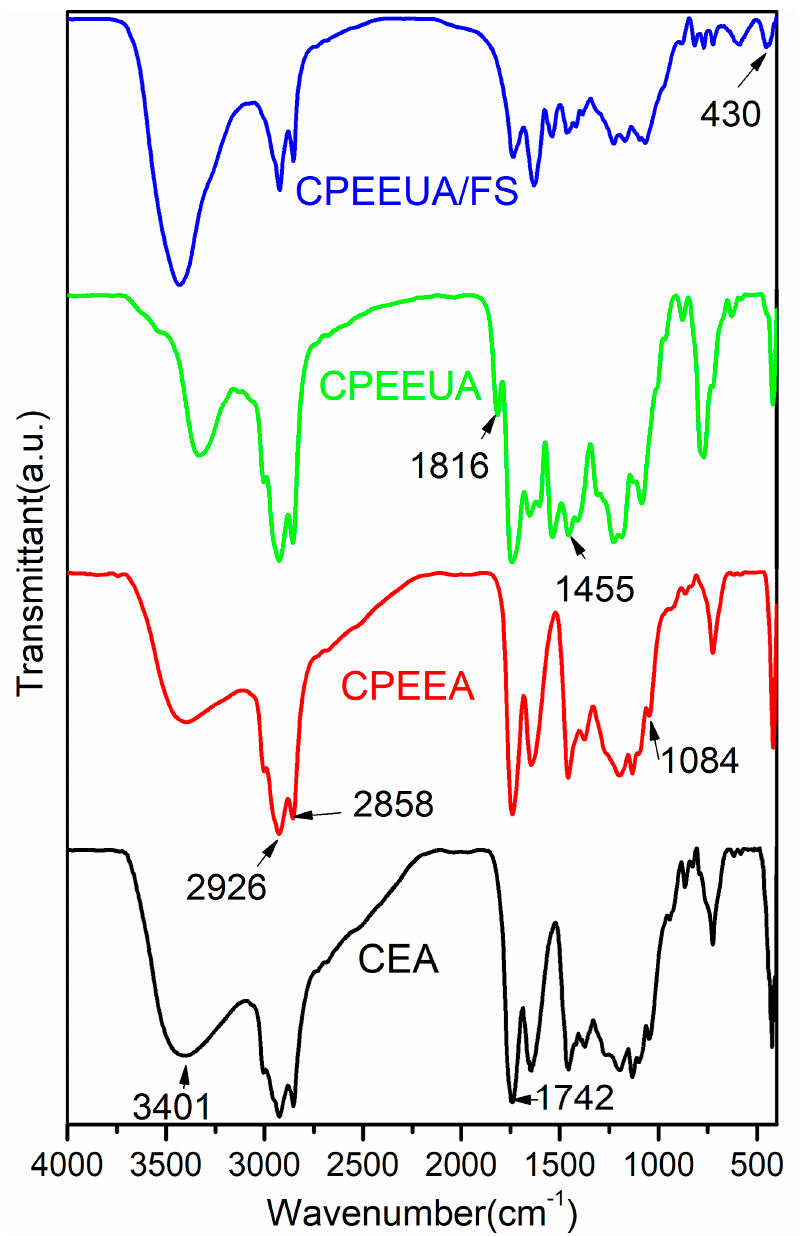
Figure 1. FTIR spectra of CEA, CPEEA, CPEEUA, and CPEEUA/FS for functional group